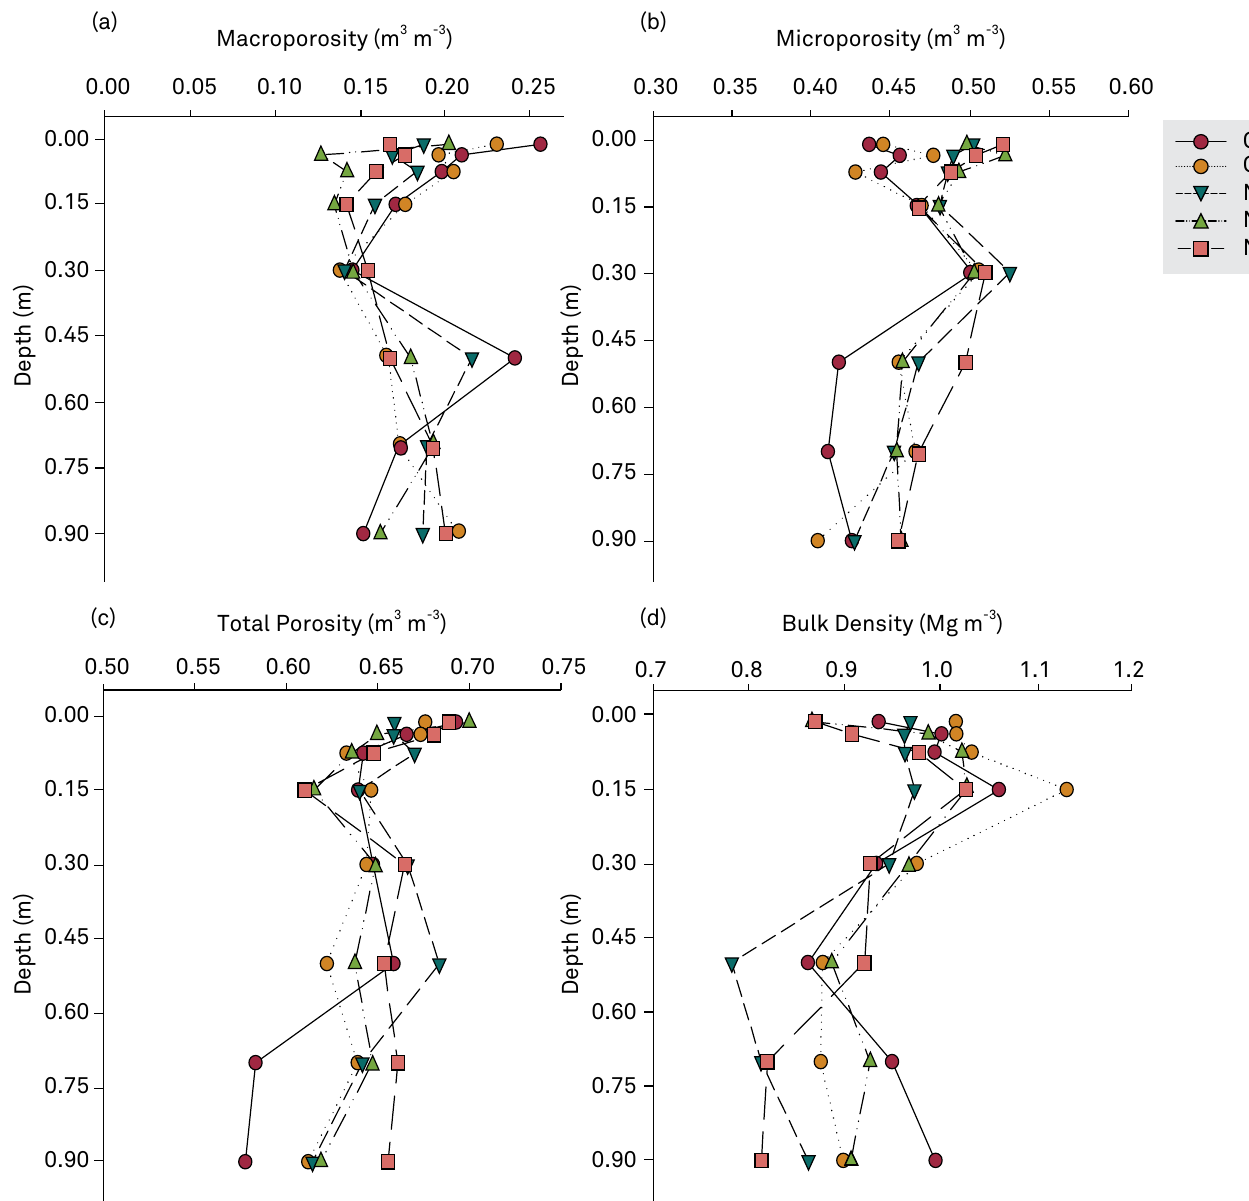
Figure 2. Macroporosity (a), microporosity (b), total porosity (c), and bulk density (d) in a Latossolo Bruno Alumínico típico (Hapludox) subjected to different tillage systems and liming methods. CTinc: conventional tillage with incorporated lime; CTwl: conventional tillage without lime; NTinc: no-tillage with incorporated lime; NTwl: no-tillage without lime; and NTsurf: no-tillage with surface